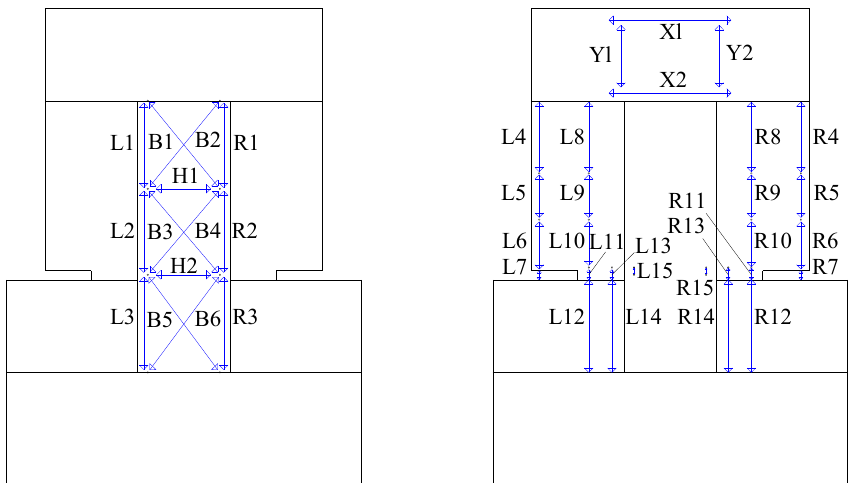
Figure 5. Locations of the linear variable differential transformers (LVDTs) on the surfaces of specimens BSH and BS.